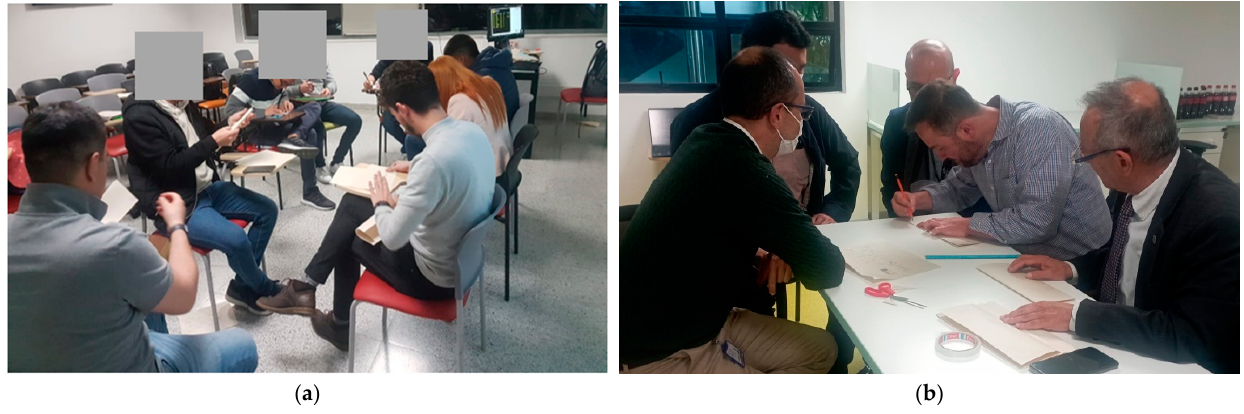
Figure 4. Validation and calibration workshops. ( a ) Step 2: Workshop with Civil Engineering Master’s students; ( b ) Step 3: Workshop with experts in engineering education. Table 4. Game evaluator